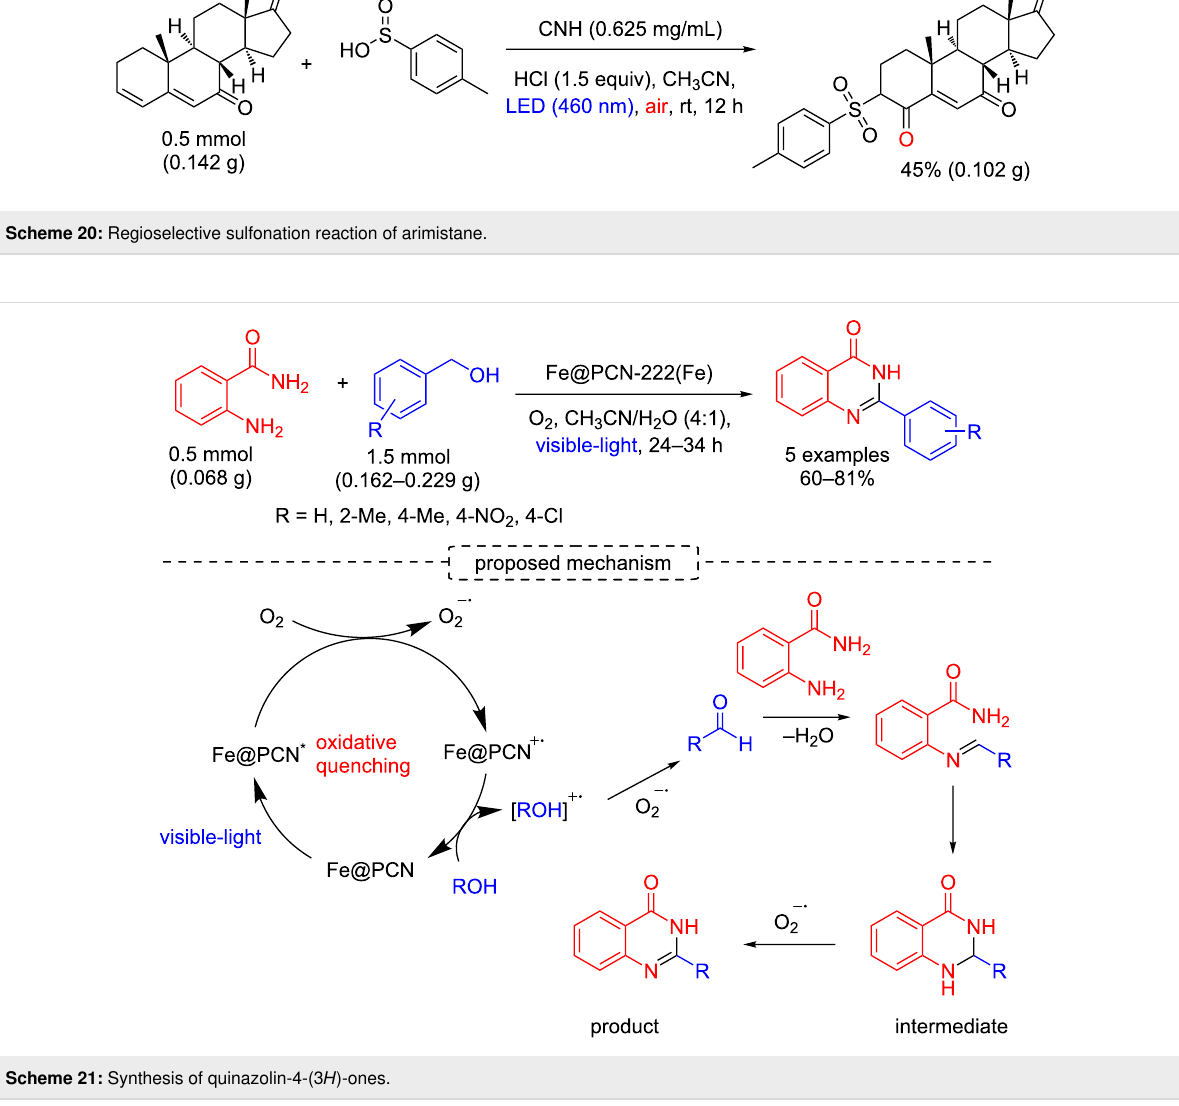
Scheme 21: Synthesis of quinazolin-4-(3 H )-ones.